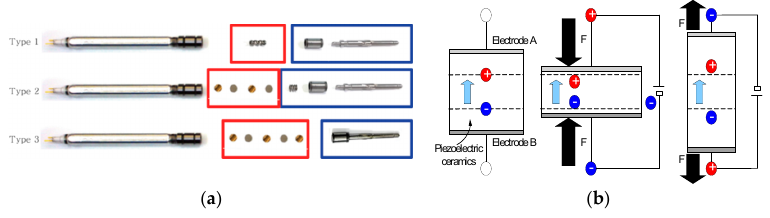
Figure 1. DPI proposed by this study; ( a ) Three prototype DPIs, ( b ) Principle of the inverse piezo-electric effect.